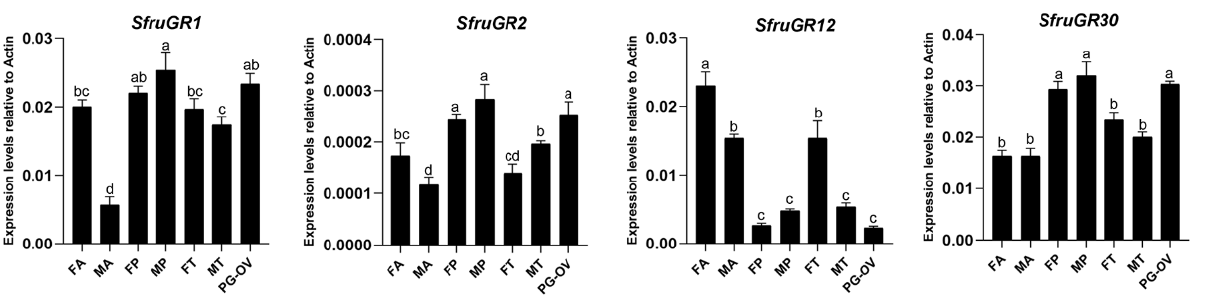
Figure 5. Expression patterns of candidate GRs in different tissues of S. frugiperda . RT-qPCR analysis of candidate GR genes was carried out in female antennae (FA), male antennae (MA), female proboscises (FP), male proboscises (MP), female tarsi (FT), male tarsi (MT), and the female pheromone gland-ovipositor (PG-OV). Values are means + SE; in each panel, means with different letters are significantly different according to a one-way ANOVA followed by a Tukey’s multiple comparison test ( p < 0.05, n =